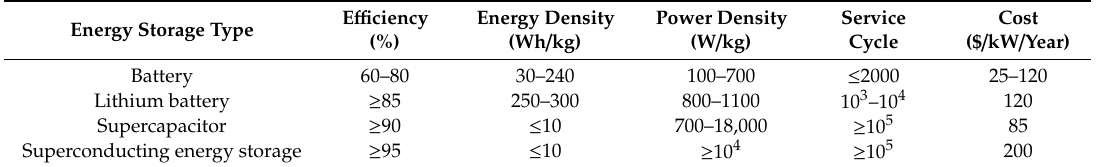
Table 1. Main parameters of common energy